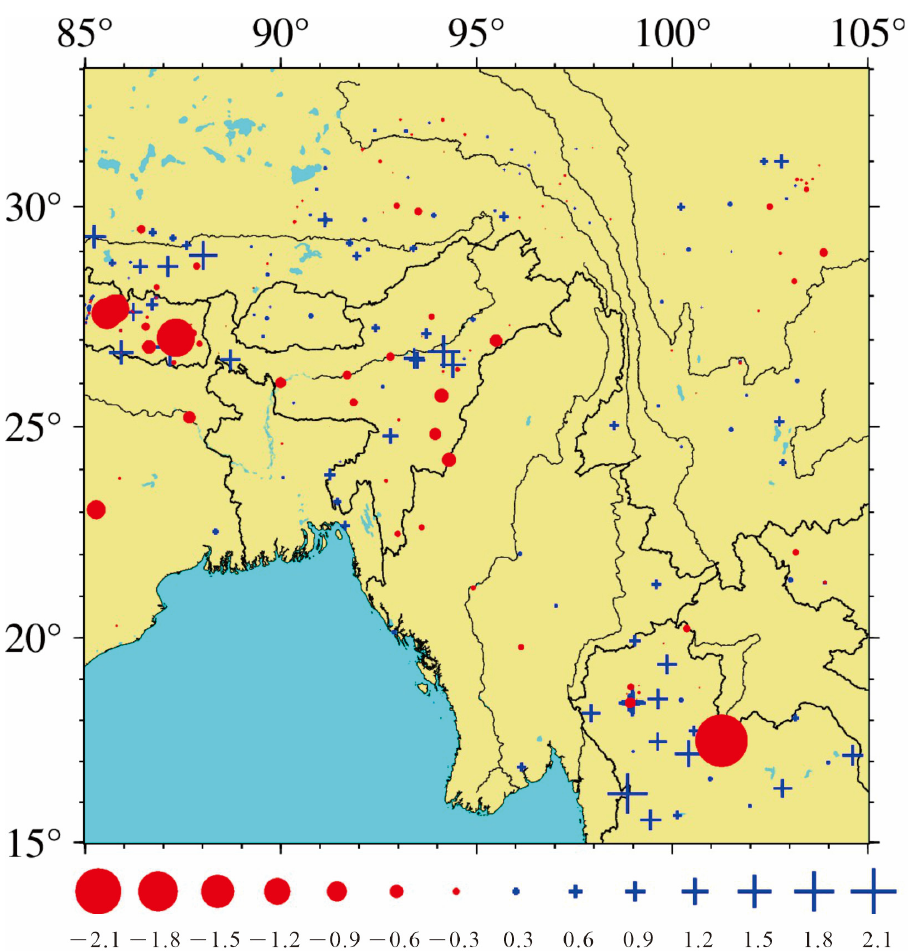
Figure 3. The relative travel-time residual distribution of all seismic events received by each seismic station. A solid red circle indicates late arrival, and a blue plus sign indicates early arrival; their proportions are shown at the bottom.